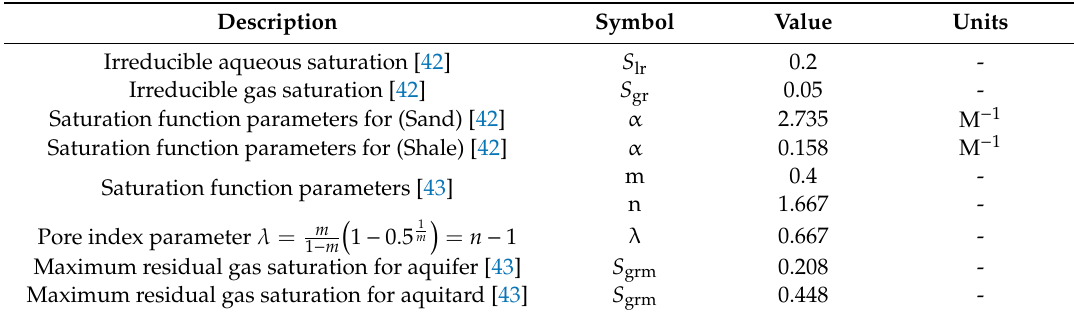
Table 2. Capillary pressure–saturation; permeability functions parameters of the simulated aquifer, after